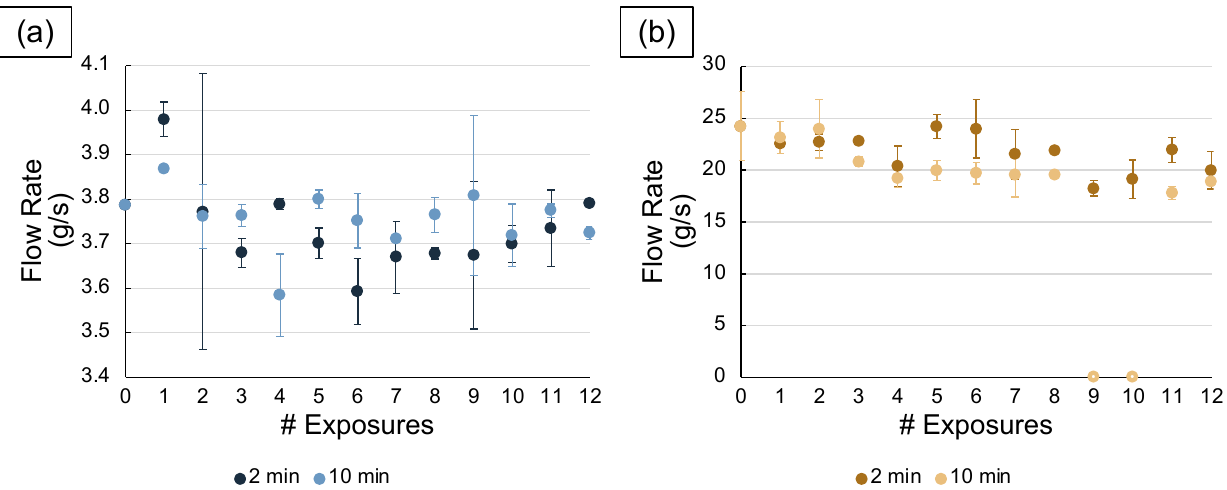
Figure 3. Flow rate (in g/s) of ( a ) the Al 5056 powder and ( b ) the Ta powder for Lots #0 through #12 (0 to 12 exposures) at both exposure durations (2 min and 10